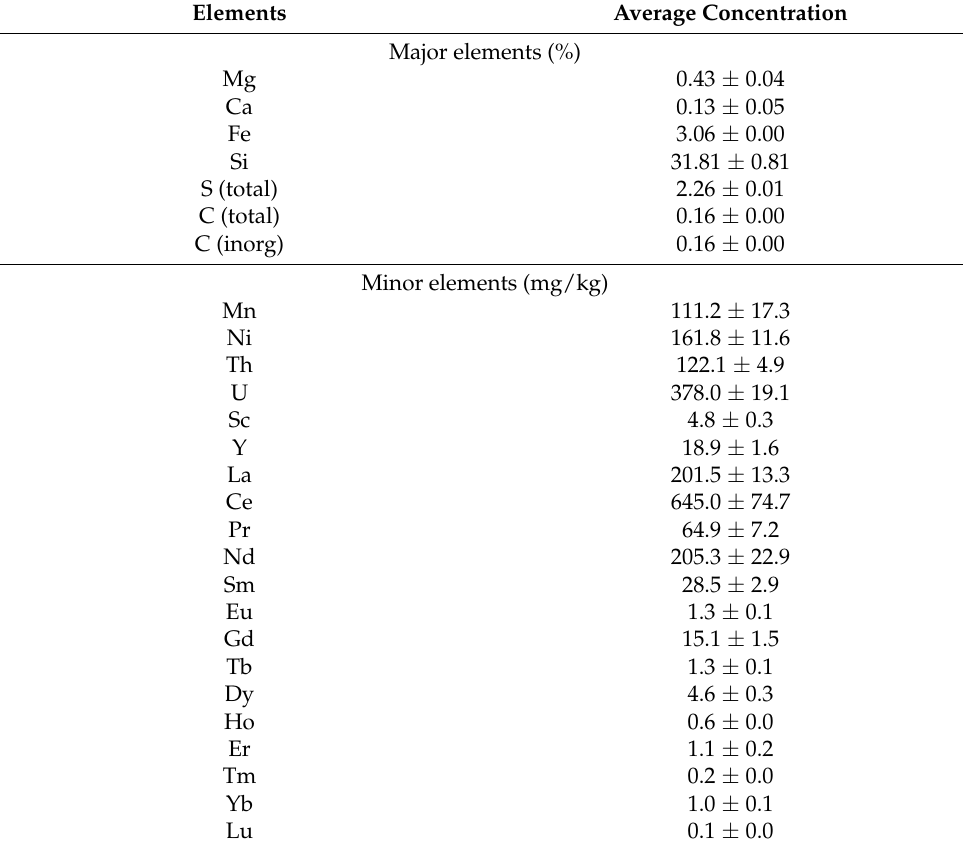
Table 5. Element concentrations measured in the BHP